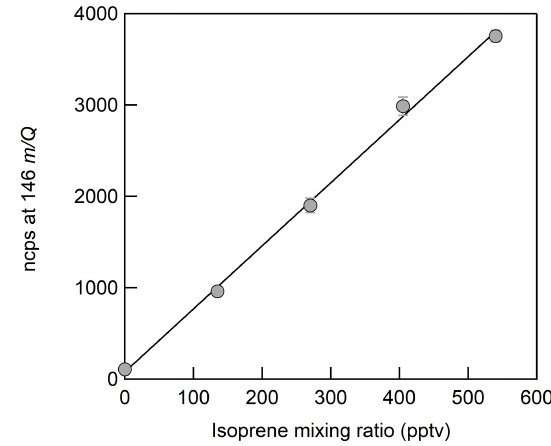
Figure 3. CI-ToFMS calibration curve for isoprene, detected · C as C 6 H + 5 H 8 at 146 m/Q . The sensitivity (slope) is 7ncps, 6 R 2 = 0.99. Error bars represent the standard deviation of the trip- licate